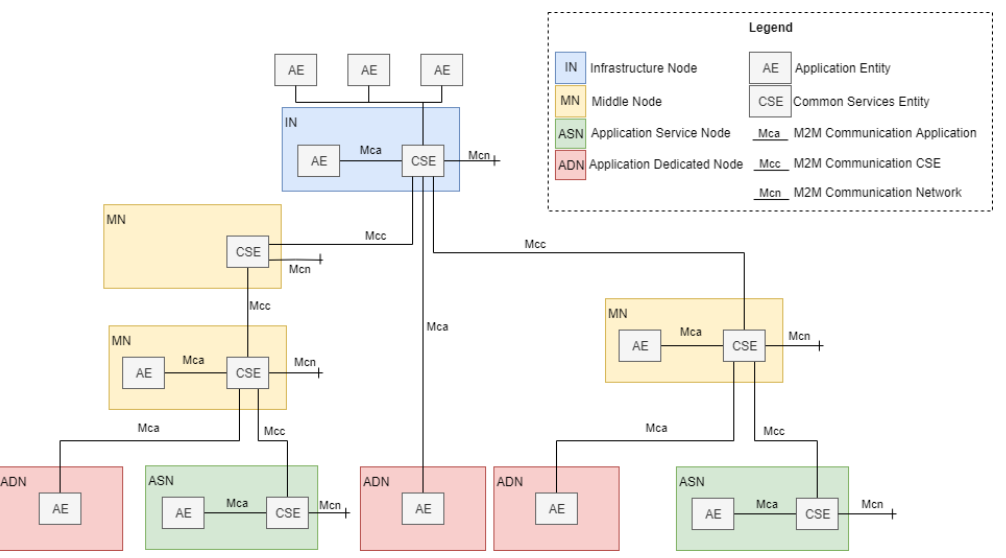
Figure 2. OneM2M functional